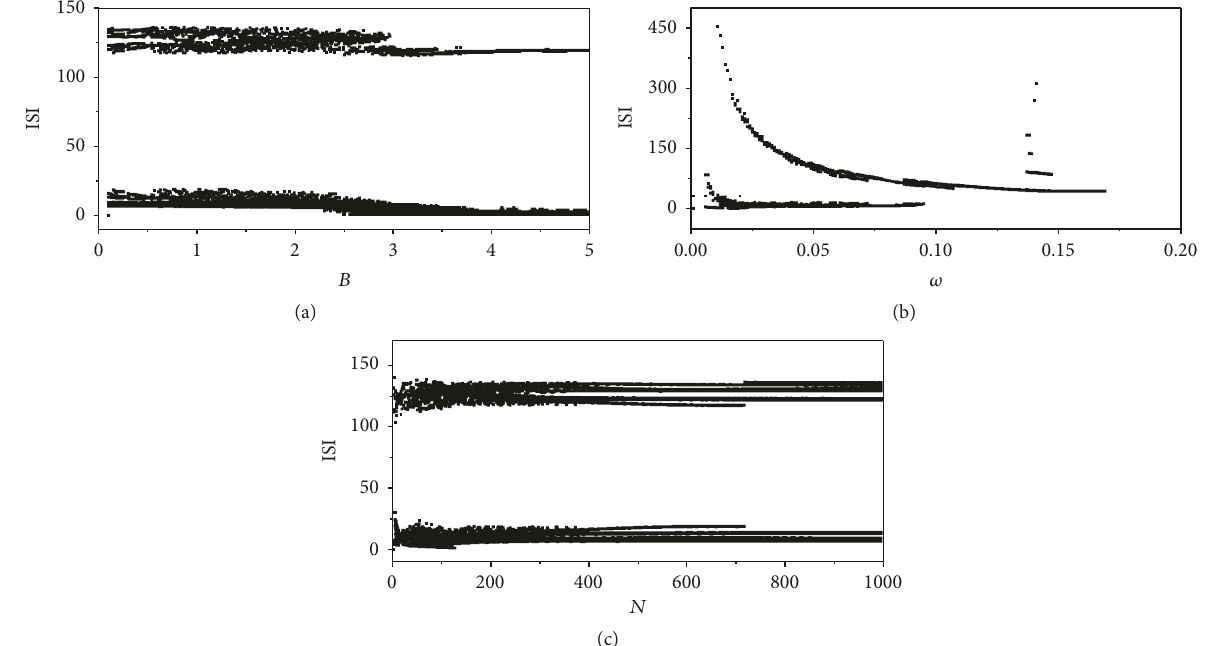
Figure 3: Bifurcation diagram with the increasing of different parameters. (a) 𝐴 = 1.6 , 𝜔 = 0.04 , and 𝑁 = 200 . (b) 𝐴 = 1.6 , 𝐵 = 1.6 , and 𝑁 = 200 . (c) 𝐴 = 1.6 , 𝐵 = 1.6 , and 𝜔 = 0.04 .